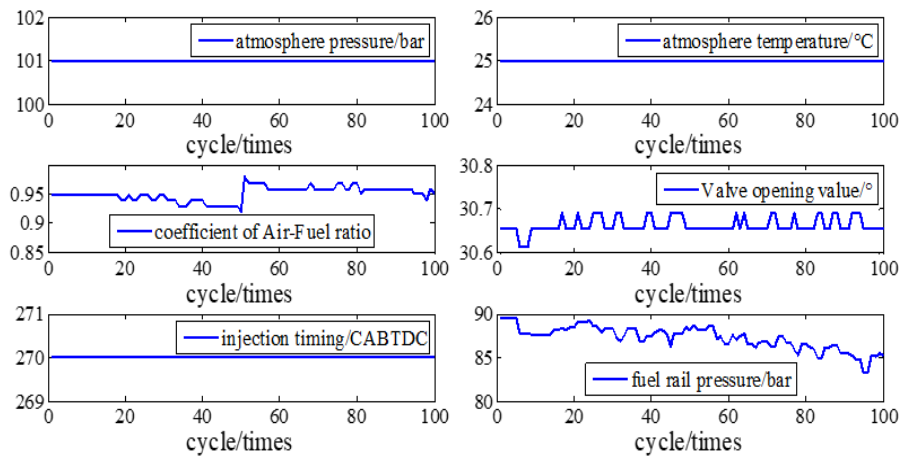
Figure 12. Error percentage of IMEP at A/F ratio 0.85 per cycle.